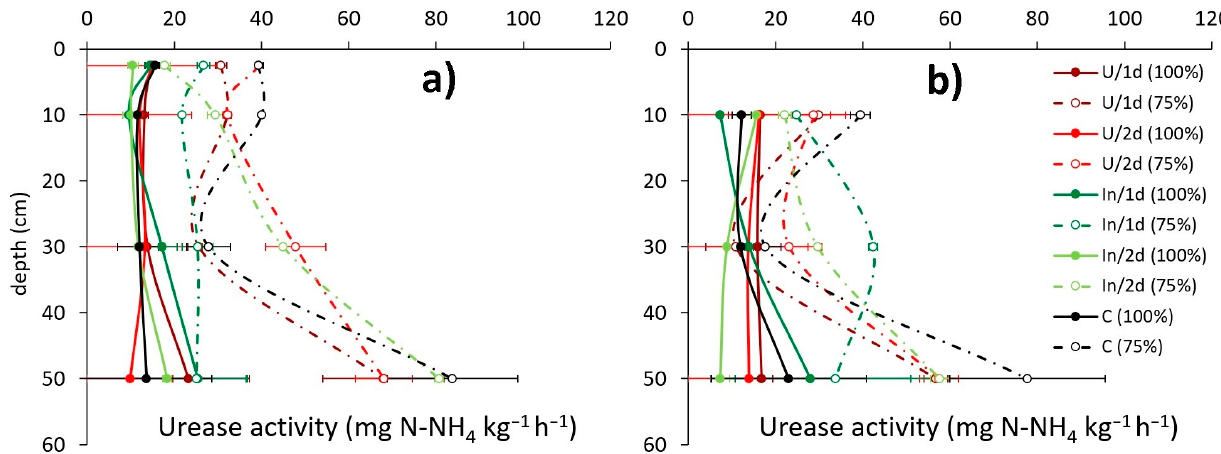
Figure 7. Soil urease activity along the soil profile at maize ( a ) flowering and ( b ) harvest. Bars represent the standard error. Treatments were a combination of urease inhibitor use (In), simple urea use (U), or no fertilizer (C), with fertilizer application in one (1 d) or two (2 d) dressings and optimally irrigated (100%) or sub-optimally irrigated (75%).